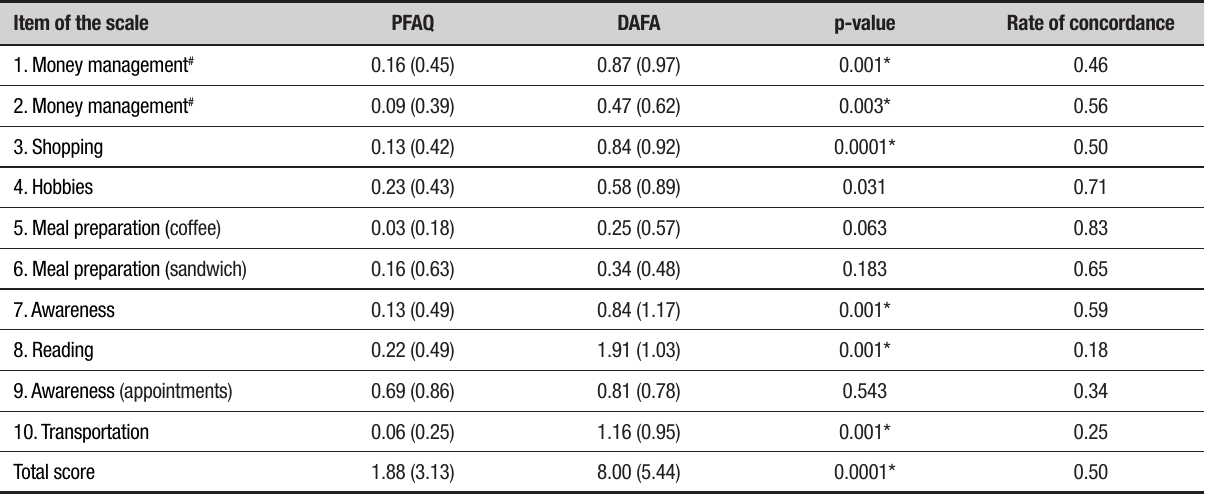
Table 2. Comparison between DAFA and PFAQ scores in PD patients with suspected mild dementia. Item of the scale